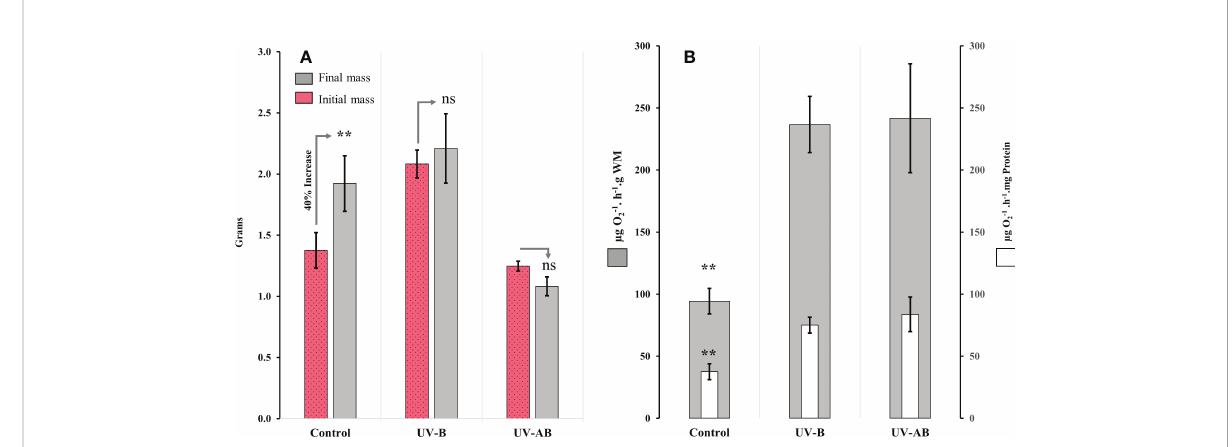
FIGURE 2 Body mass and aerobic respiration response of Cassiopea to UVR. (A) Wet body mass at the beginning and the end of the experiment; N = 8 (control), 6 (UV-B), and 6 (UV-AB). Statistical signi fi cance was calculated using Wilcoxon signed-rank test. (B) Mitochondrial electron transport system (ETS) activity in oral arms at the end of the experiment; N = 8 (control), 6 (UV-B), and 5 (UV-AB). Bars present the data in two normalization methods: 1- activity per wet body mass (i.e., external bars), 2- activity per total protein content (internal bars). Statistical signi fi cance was tested using Dunn (1964) Kruskal – Wallis multiple comparison test. In both panels, Data represent the mean ±SE. An asterisk above bars means statistical signi fi cance ( ∗ p ≤ 0.05 , ∗∗ p ≤ 0.01 ). An “ ns ” above the bars indicates nonsigni fi cant